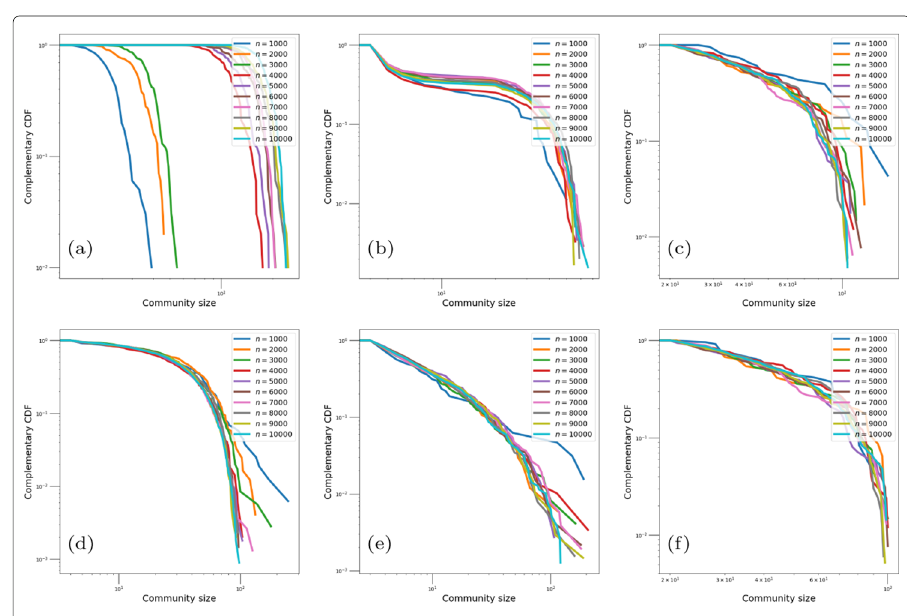
Fig. 4 Variation of the number of nodes ( n ) for LFR synthetic networks considering the community size: a Bigclam; b CFinder; c Copra; d Demon; e SLPA; f